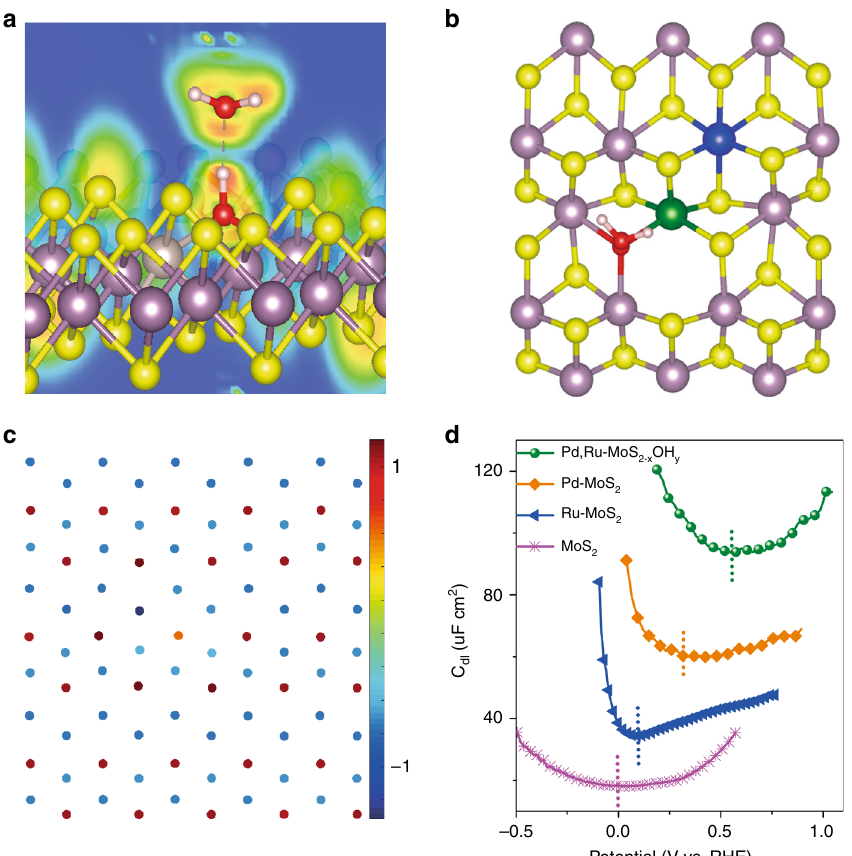
Fig. 3 Using theoretical and experimental techniques to understanding the di-anionic effect. a Electron localization function (ELF) evaluations. b Interaction energy between H 2 O and the surface – OH sites. c Bader charge analysis. d E PZC measured for Pd, Ru – MoS 2 − x OH y , Ru – MoS 2 , Pd – MoS 2 , and MoS 2